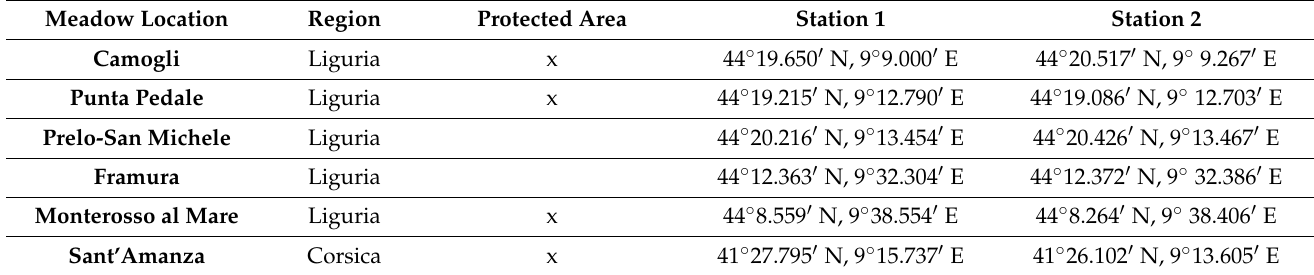
Each site represents a different level of ‘naturalness’, according to the degree of human pressure along the coast and to the protection regime [40]. Camogli and Punta